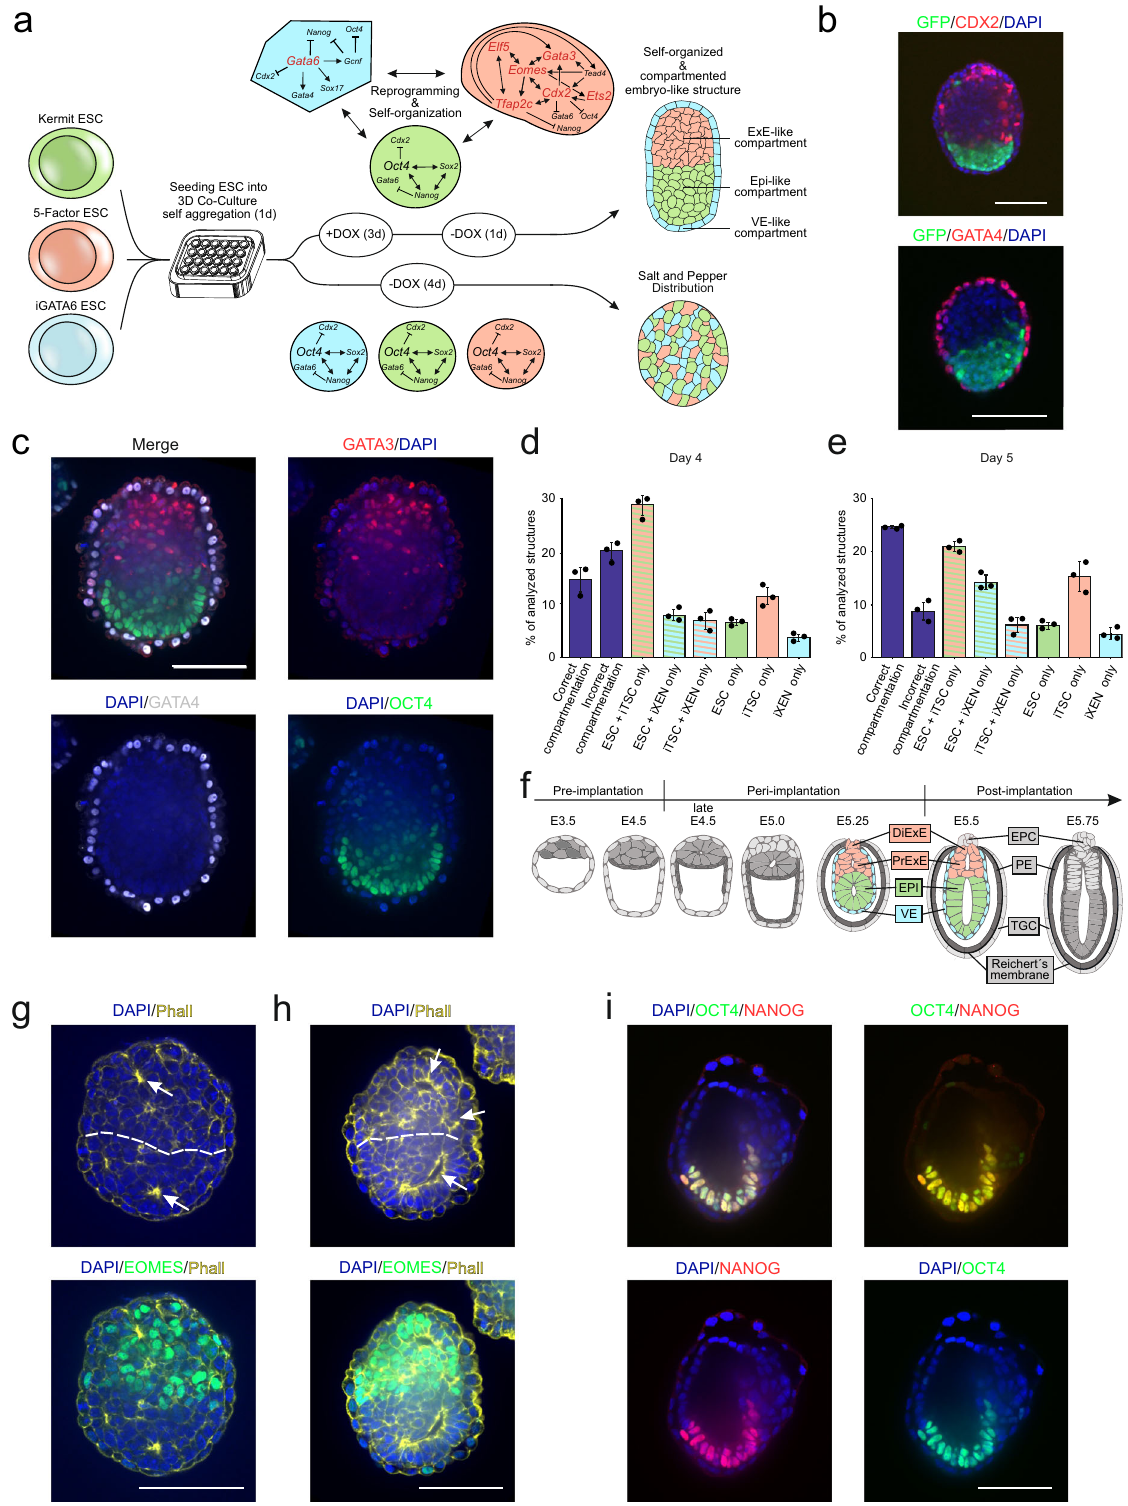
suggesting successful reprogramming and self-organization (Fig. 1d, e). Of note, this is comparable to ef fi ciency rates reported for other embryo model approaches, like ETX embryos (29.8%) 8 , iETX embryos (between 20 and 30%) 10 , and ETX- embryoids (~23%) 9